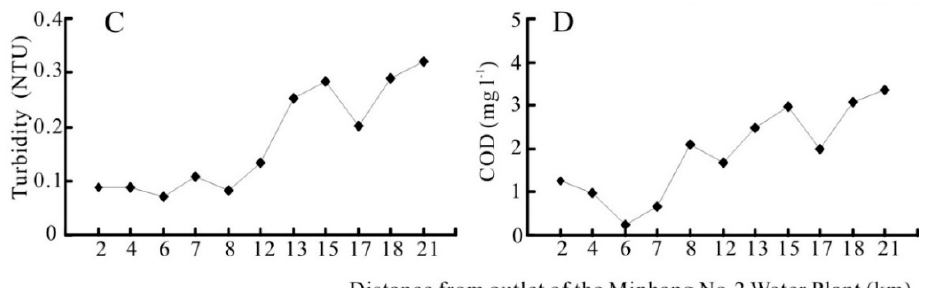
Figure 6. The deterioration of water quality during delivery via pipeline. ( A ) decreasing residual